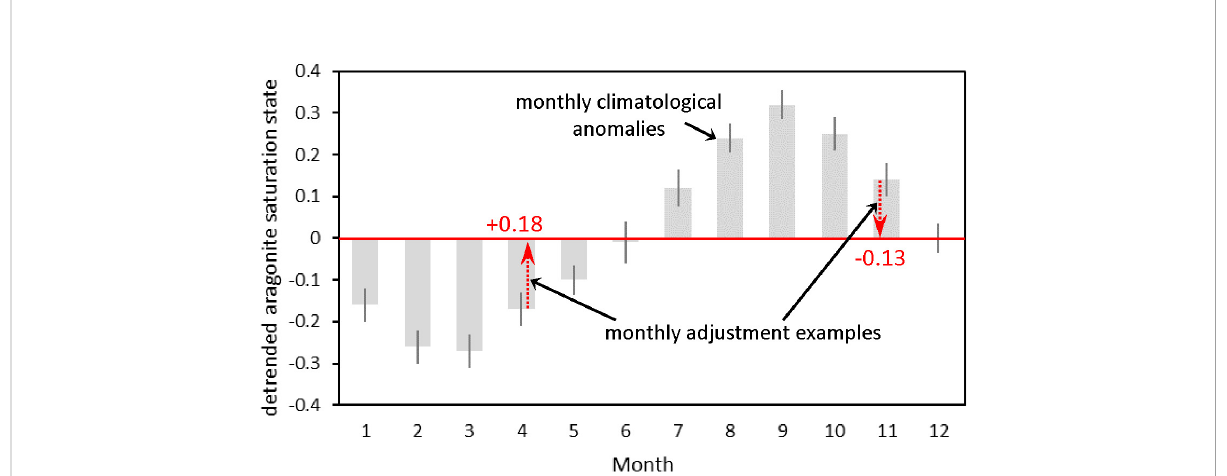
FIGURE 4 An example surface seawater aragonite saturation state monthly climatology from the Kuroshio Extension Observatory (KEO) mooring showing monthly mean (gray bars) and standard deviation (error bars) of de-trended values, shown as anomalies around zero, which represents the annual climatological mean (red solid line) as in Figure 3B. Two examples of the monthly adjustments are also shown for April (+0.18) and November (-0.13) derived from these climatologies. The adjustments will be applied to the time series of monthly means to remove the seasonal cycle. In practice, adjustments are calculated and applied for all twelve